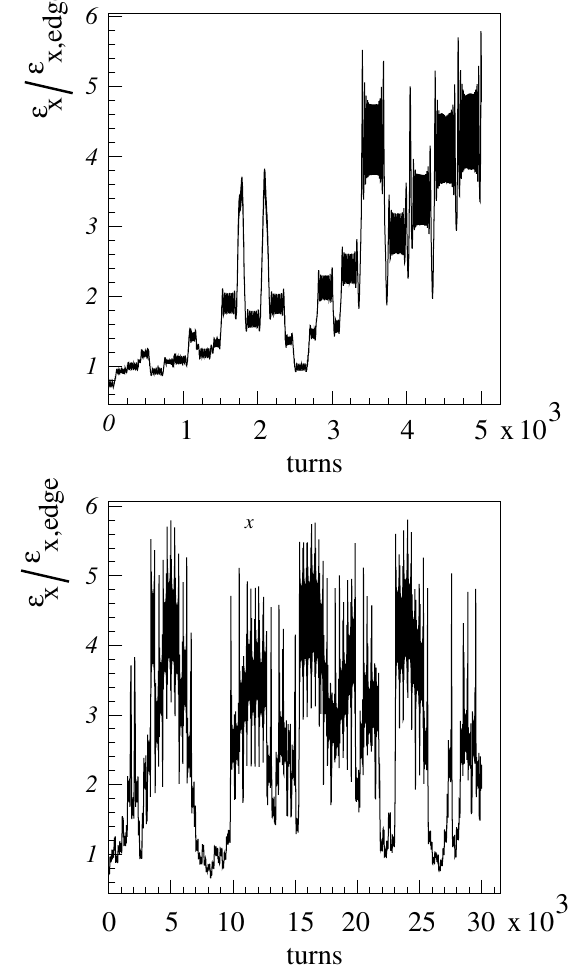
FIG. 8. Trapping and detrapping of a single test particle and (cid:2) 6 : 257 . Shown are transverse relative single-particle emit- Q x tances as functions of turns (top frame zoom of bottom frame abscissa).